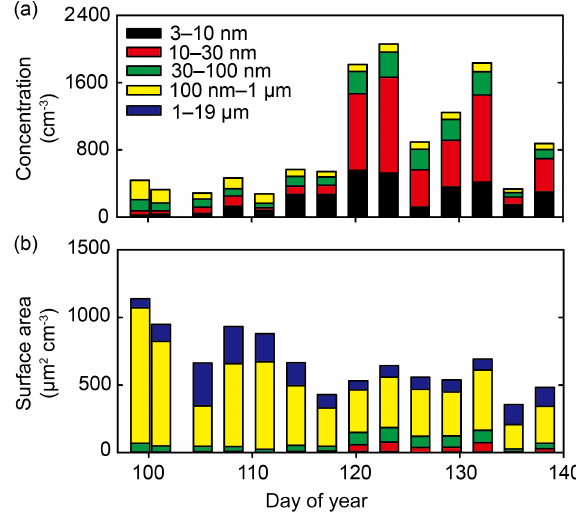
Figure 3. (a) Concentration, and (b) surface area of aerosol par- ticles, including nucleation-mode (3–10nm), Aitken-mode (10– Figure 2. (a) The concentrations of nss-SO 2 − (blue line), and MSA 4 100nm), accumulation-mode (100nm–1µm) and coarse-mode (1– (red line) at the Gruvebadet observatory in April and May 2015. 19µm) particles in April and May 2015. (b) The relationship between nss-SO 2 − and MSA measured in 4 April (blue circles; Arctic haze period) and in May (red circles; phy- toplankton bloom period). The red solid line shown in (b) indicates the best fit.